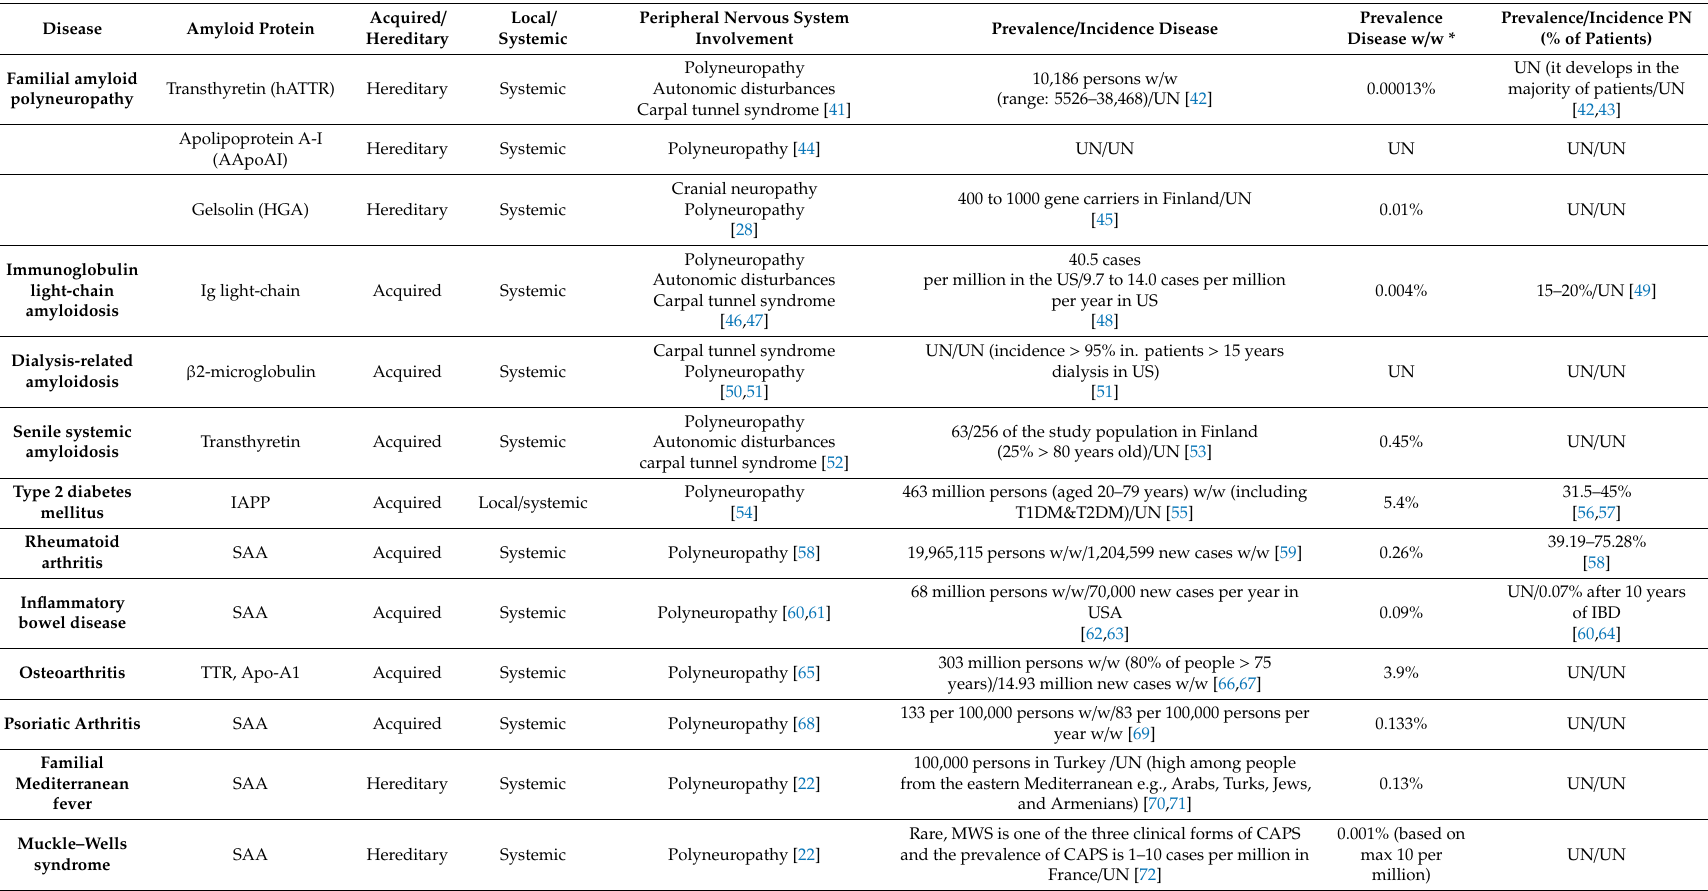
Table 1. Diseases with known peripheral nervous system involvement and a (potential) link to amyloid